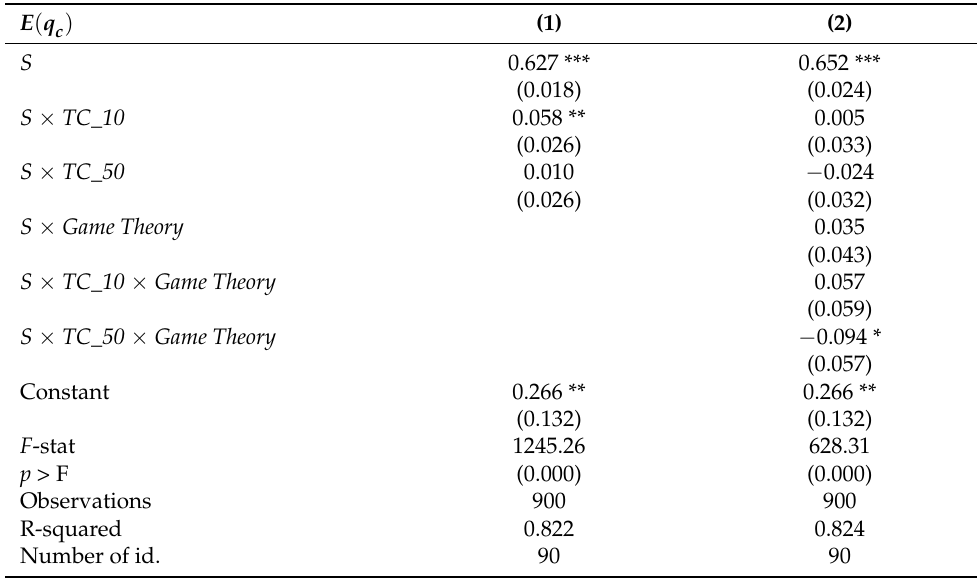
Table 7. Aggregate (trustors and trustees) expectations of the corruption